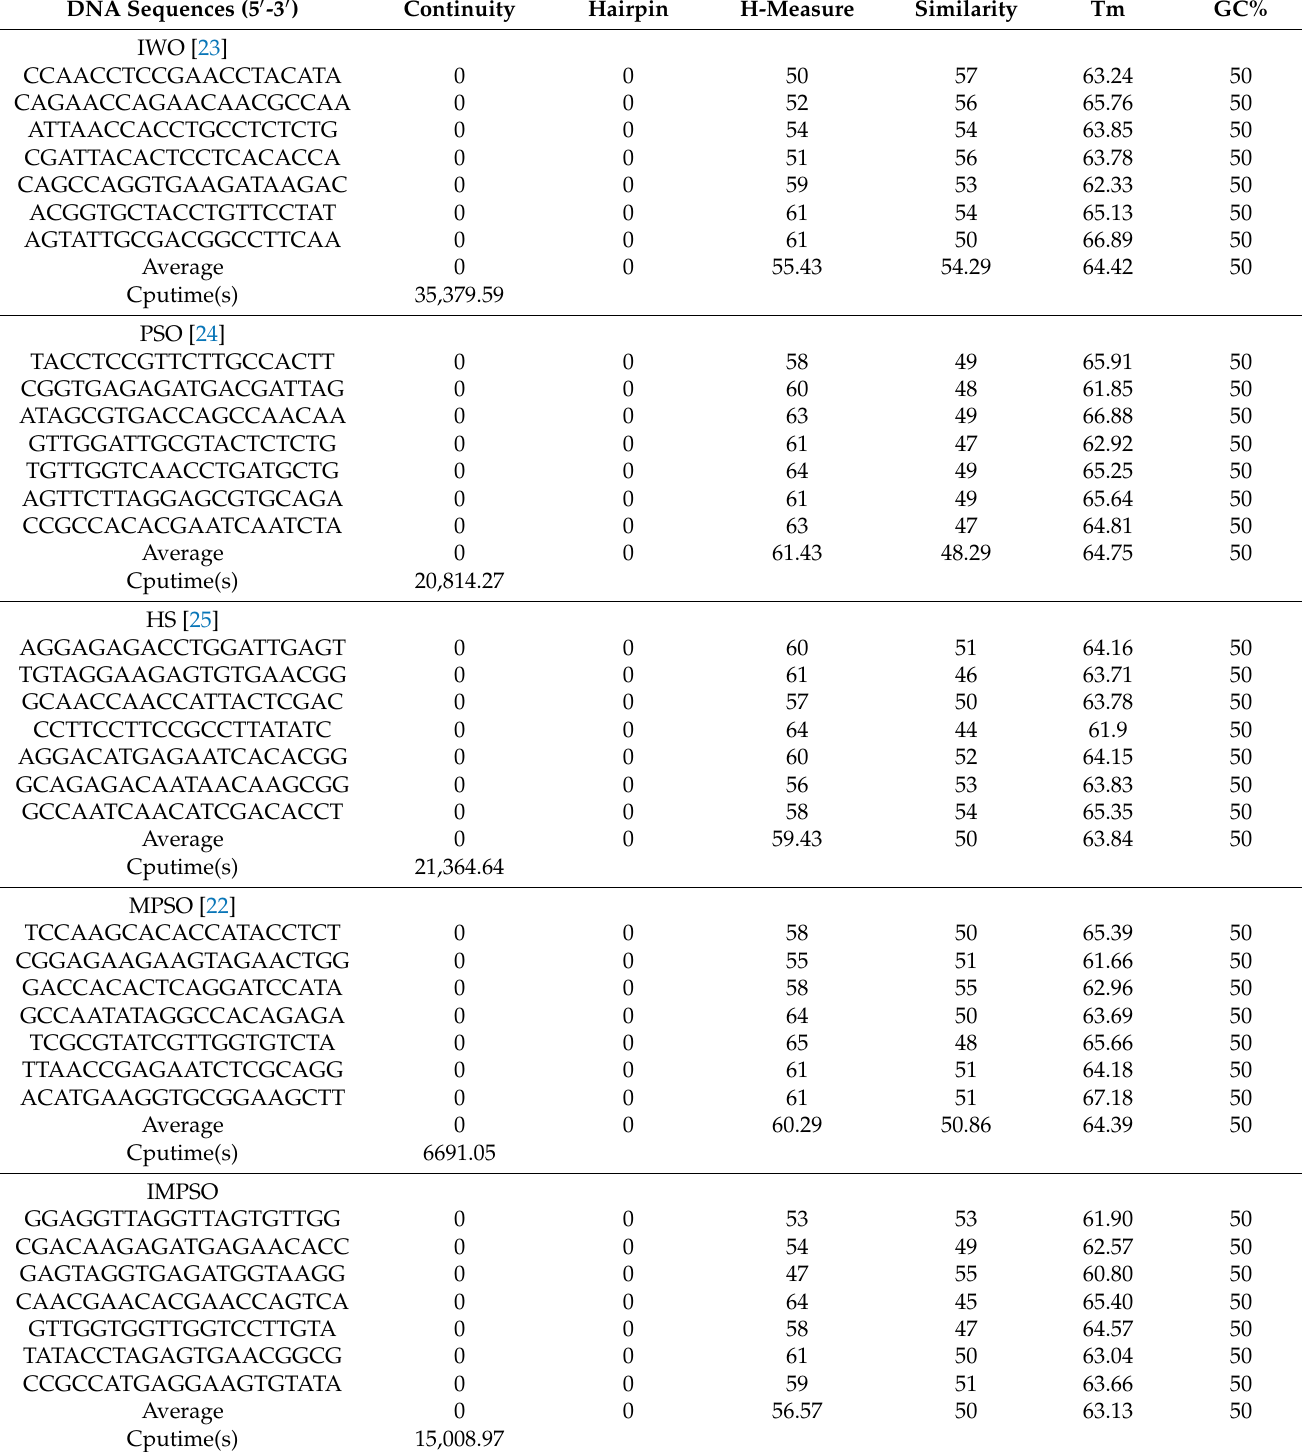
Table 3. Comparison of DNA sequences and their constraint values and